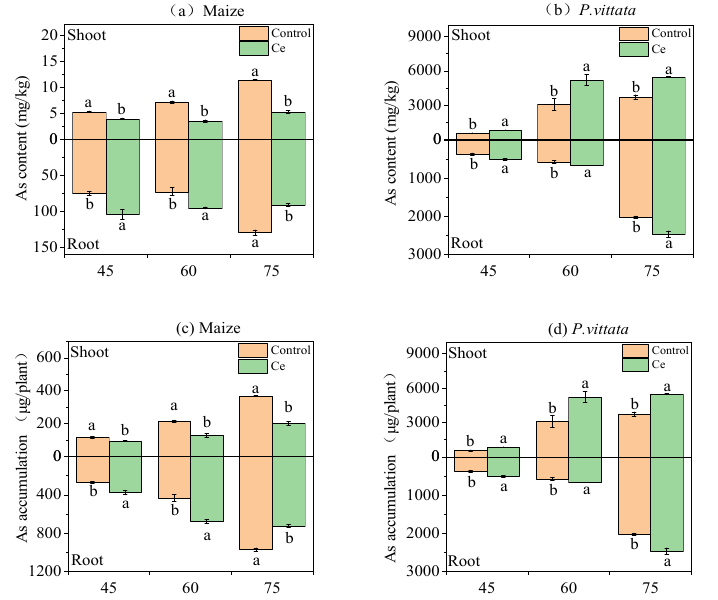
Figure 1. Effects of Ce colonization on As content ( a , b )and accumulation ( c , d ) in maize and P. vittata , respectively, under As stress. As: arsenic; Ce, Claroideoglomus etunicatum . Lowercase letters “a” and “b” in the same group in the graph indicate significant differences between treatments ( p < 0.05).